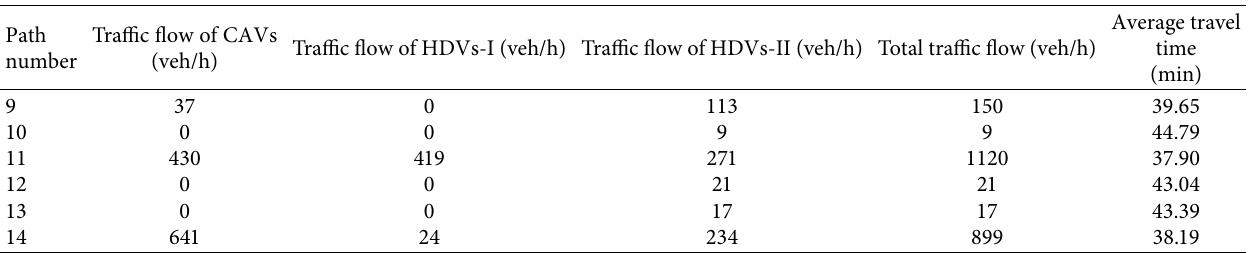
Figure 4: Evolution of path flow with iterations. (a) OD pair 1. (b) OD pair 2. (c) OD pair 3. (d) OD pair 4. Table 14: Path data of OD pair 2 in equilibrium